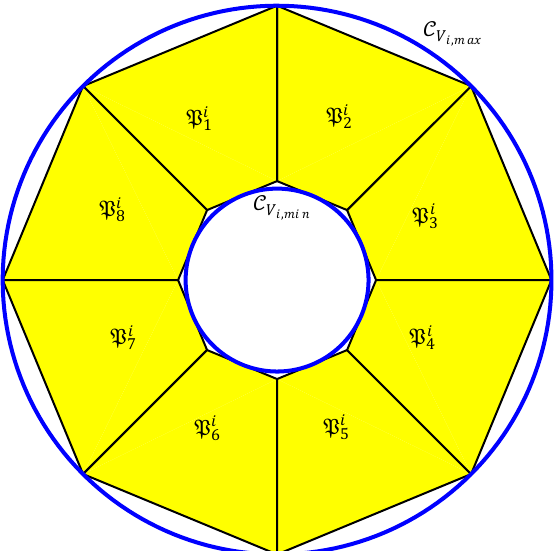
Figure 4. Velocity vector domain and its polytopic approximation. Blue circles represent the maximum and minimum allowed